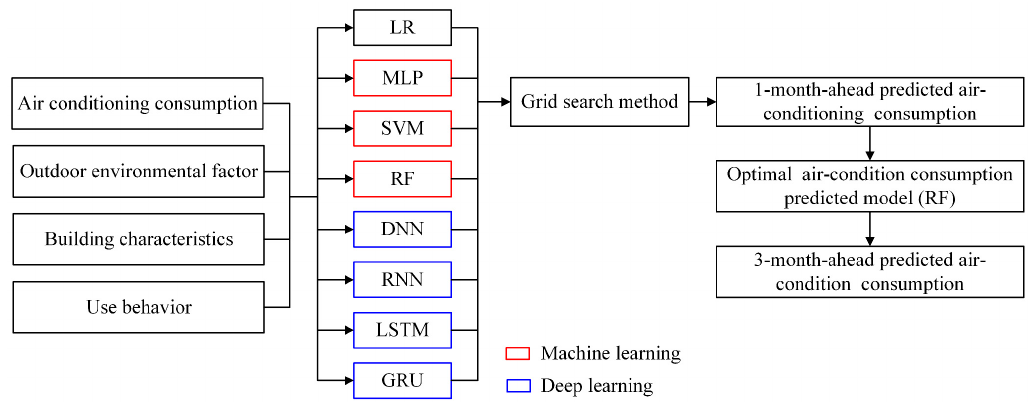
Figure 6. Flowchart of the proposed model. Table 4. The Candidate parameters of the models.